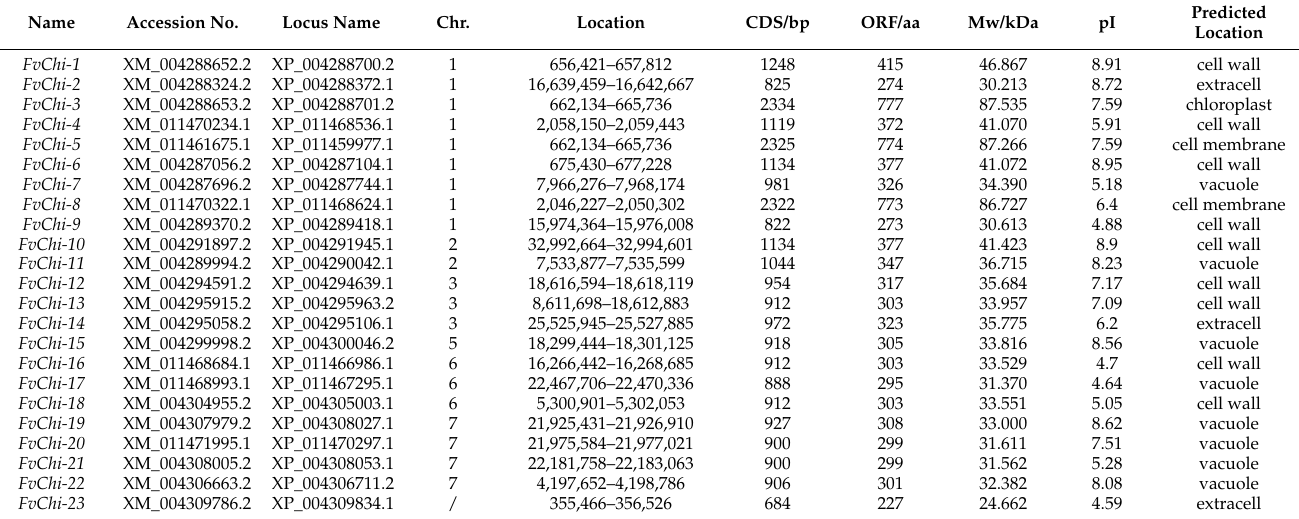
Table 1. The details of chitinase genes identified in F. vesca .